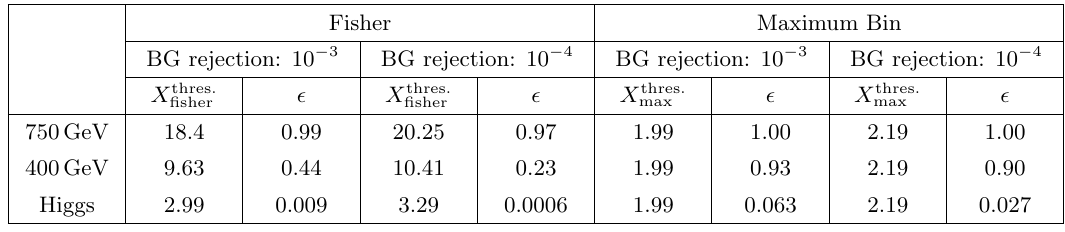
Table 3. Thresholds ( X thres. and X thres. ) and corresponding signal e(cid:14)ciencies ( (cid:15) ) for Fisher and max (cid:12)sher Maximum Bin discriminators, for background rejection rates of 10 (cid:0) 3 and 10 (cid:0) 4